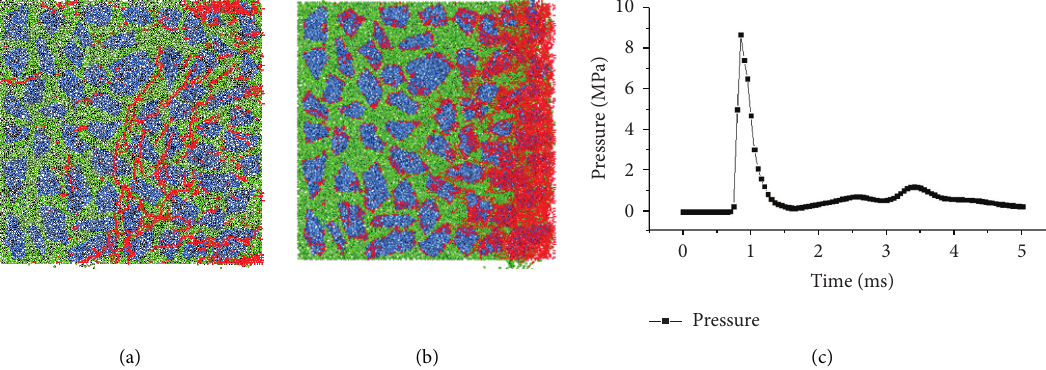
Figure 20: (a) The damage of point D4 at normal temperature, (b) the damage of point D4 at 600K, and (c) the compressive wave.